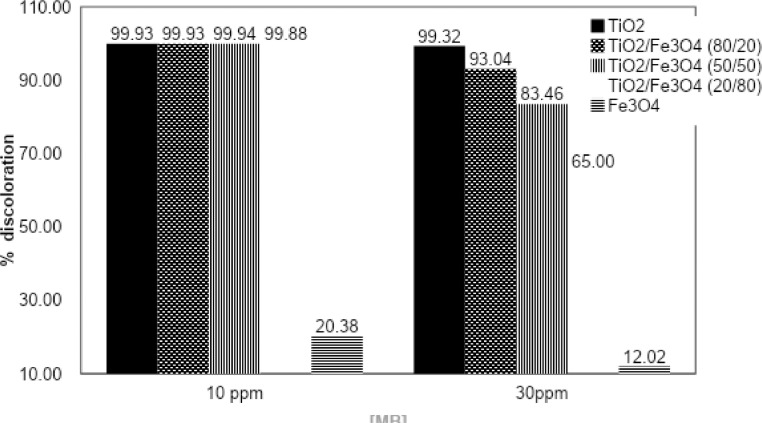
MB discoloration under simulated solar reactor by catalysts of TiO2, TiO2/Fe3O4 and Fe3O4. [catalyst] = 0.3 g/L.